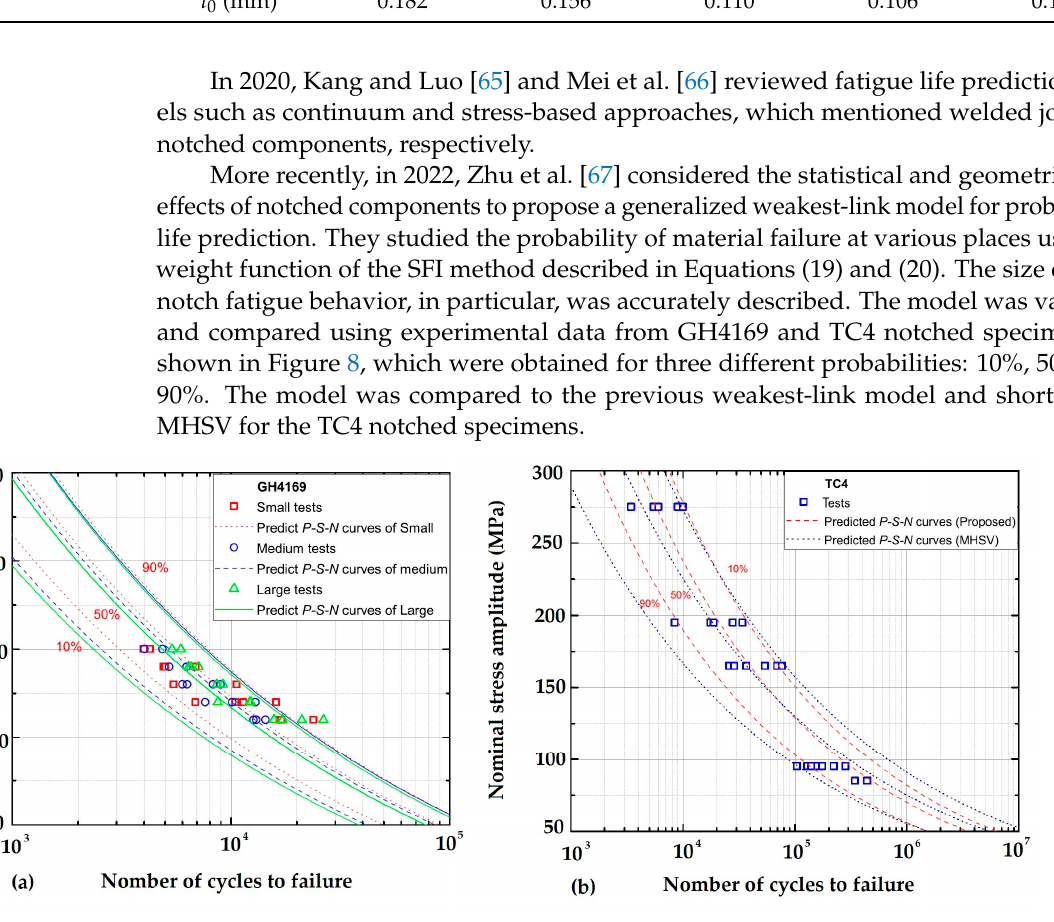
Figure 8. Predicted P-S-N curves for ( a ) GH4169, ( b ) TC4 notched specimens [67].